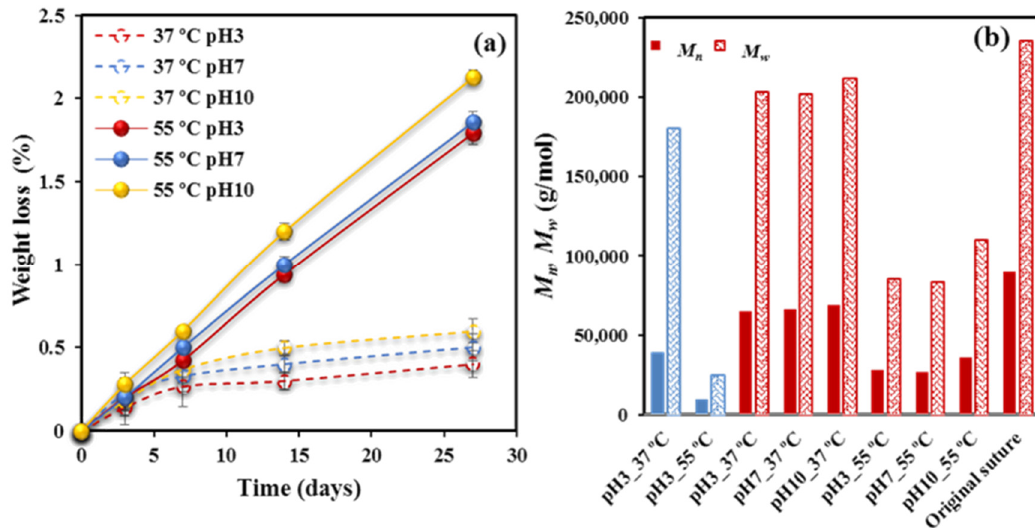
Figure 1. ( a ) Weight loss versus exposure time for P4HB sutures exposed to hydrolytic media of pH values of 3, 7, and 10 at temperatures of 55 °C (solid lines) and 37 °C (dashed lines). ( b ) M n (full bars) and M w (weave bars) molecular weights of the initial suture and after exposure for 27 days to the indicated media. For the sake of completeness, the results obtained from a melt pressed film are also shown (blue bars).